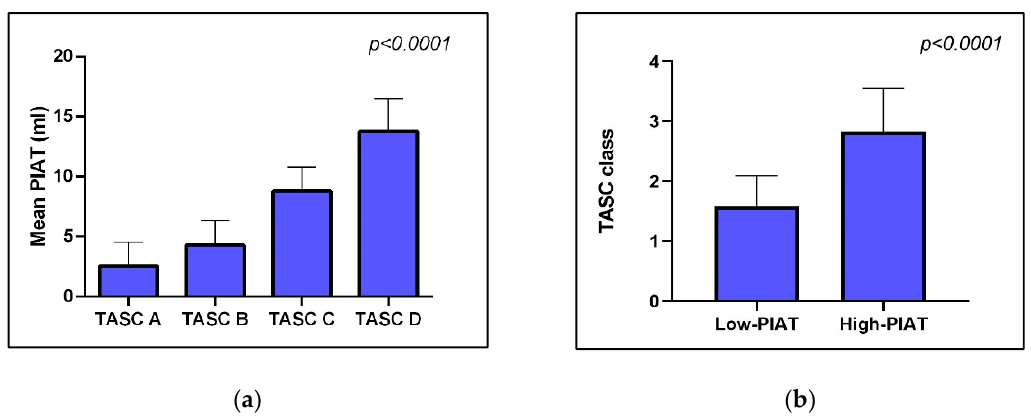
Figure 5. Association between mean PIAT volume and complexity of vascular lesions, as expressed by TASC classification. ( a ) shows that patients with increased volume of PIAT have more complex arterial lesions; ( b ) indicates that average TASC class is significantly higher in patients with higher volumes of PIAT.